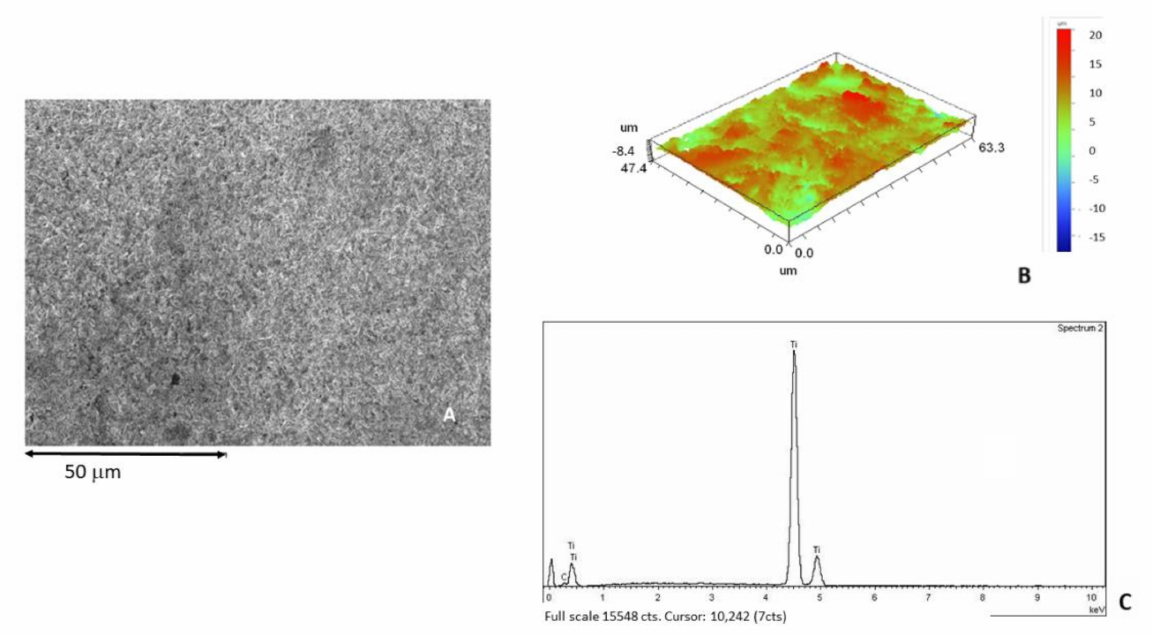
Figure 3. ( A ) Surface of the as-received sample observed by SEM. ( B ) Roughness in 3D image. ( C ) X-ray